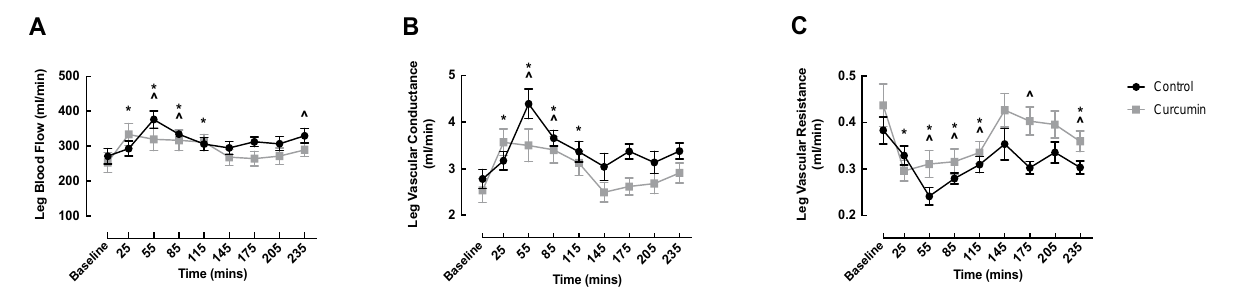
Figure 3. The impact of curcumin alongside oral nutritional supplement feeding on leg blood flow ( A ), vascular conductance ( B ), and vascular resistance ( C ) in healthy older adults. A ˆ denotes significant difference from control baseline ( p < 0.05); * denotes significant difference from curcumin baseline ( p < 0.05).